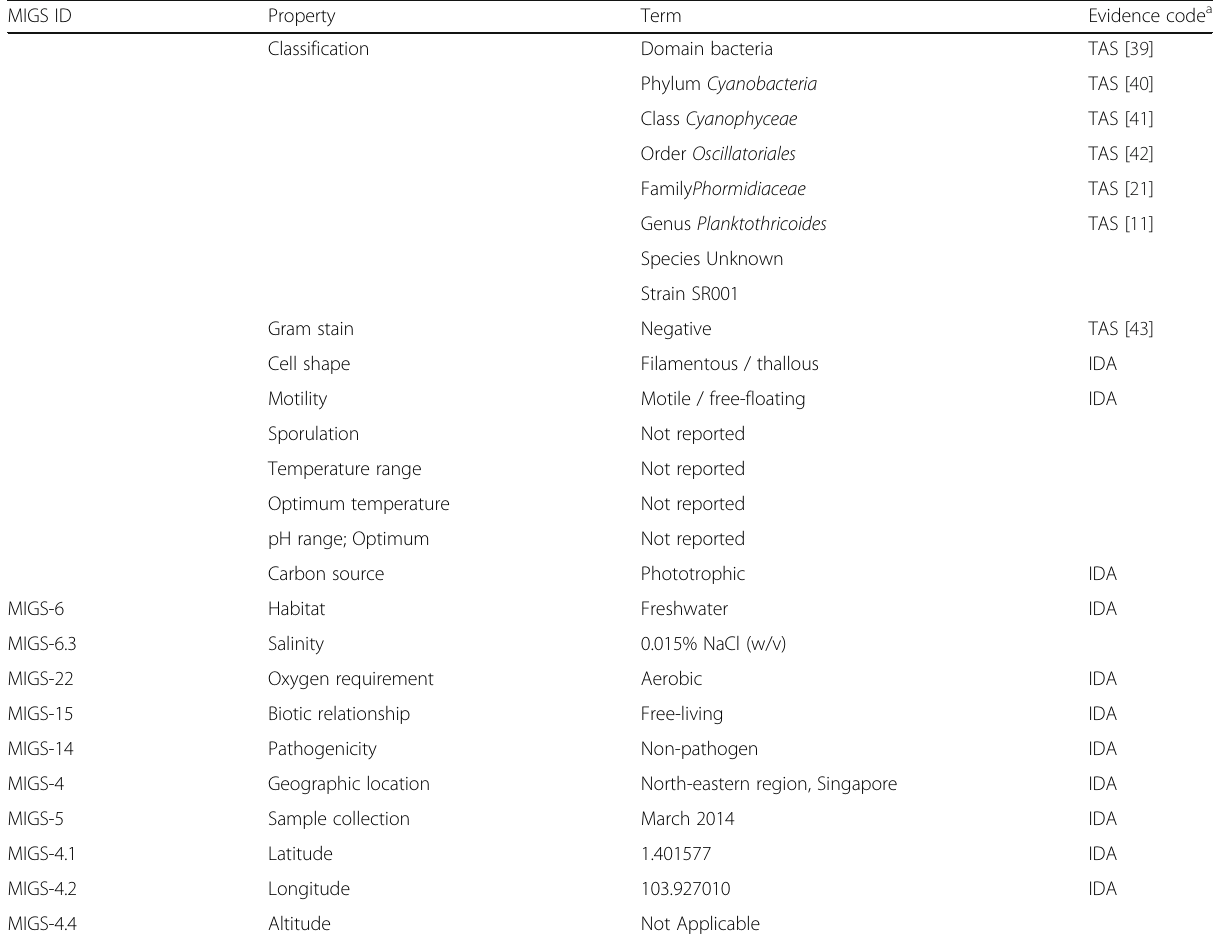
Table 1 Classification and general features of Planktothricoides strain SR001 [38] MIGS